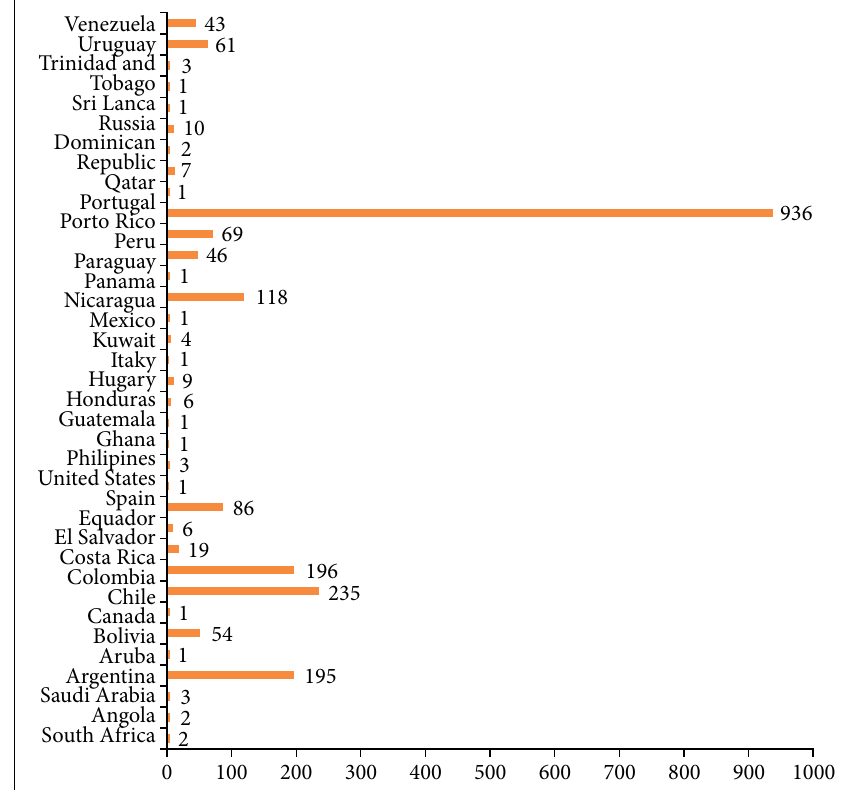
Figure 2 - Total number of international students participating in courses at IRCAD Barretos, SP, Brazil, over the 10 years and their country of